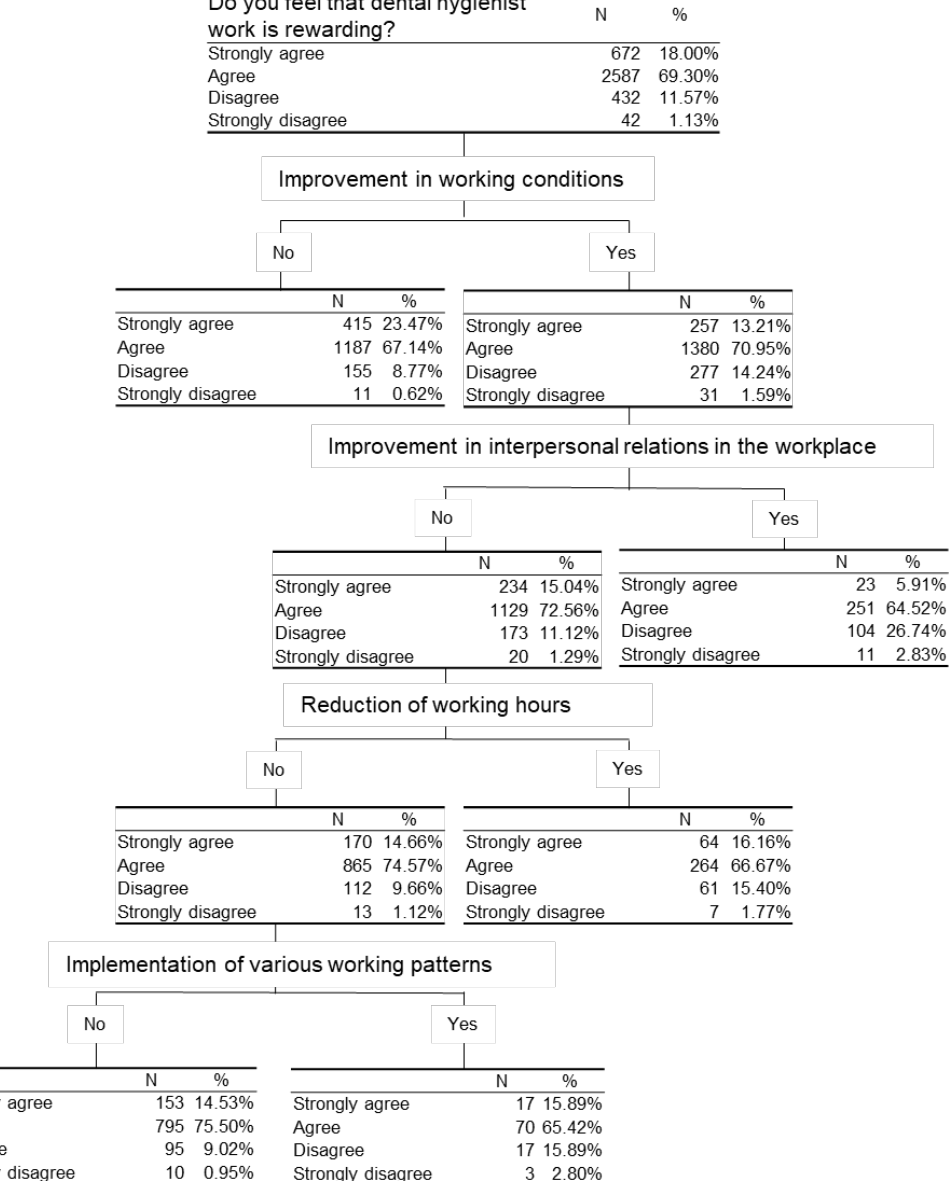
Figure 4. A decision tree to identify subjects who answered, “Strongly disagree” to the “Do you feel that dental hygienist work is rewarding?”.